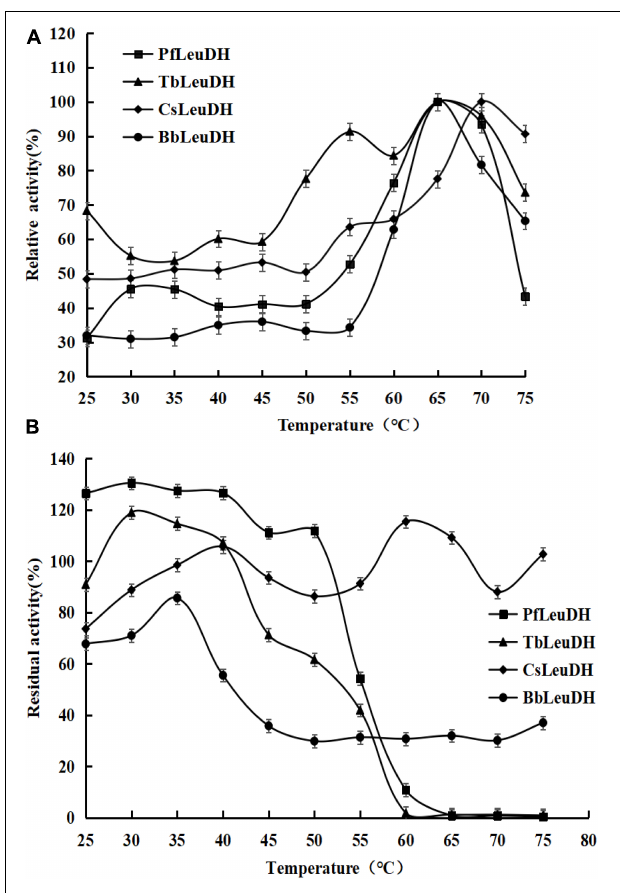
FIGURE 3 | The temperature properties of the representative recombinant leucine dehydrogenases. (A) Temperature optima of the representative recombinant leucine dehydrogenases. The temperature optima were assayed spectrophotometrically by monitoring the increase of NADH absorbance at 340 nm at reaction temperatures ranging from 25 to 75 ◦ C. (B) Temperature stabilities of the representative recombinant leucine dehydrogenases. The temperature stabilities were determined by incubating them at various temperatures (25–75 ◦ C) for 1.0 h, and then the residual enzyme activities were measured as describe in the text.